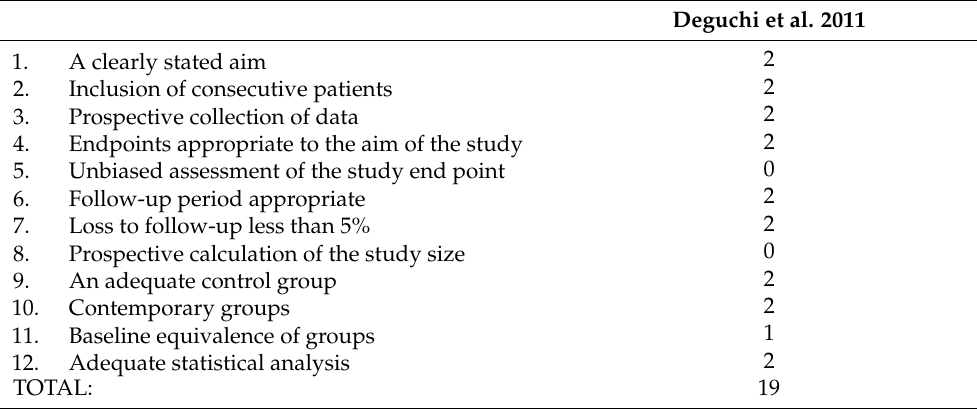
Table 2. Assessment of the risk of bias in the included articles by the methodological index for non-randomized trials tool (MINOR).